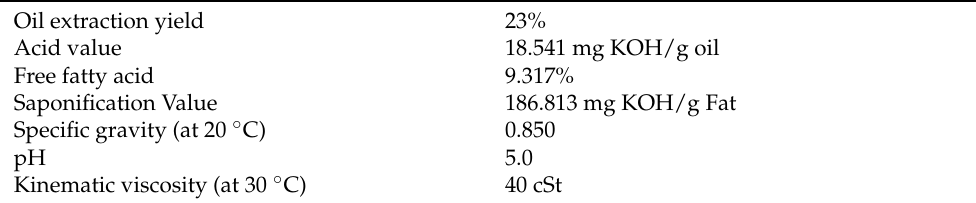
Table 1. Physiochemical properties of Kapok